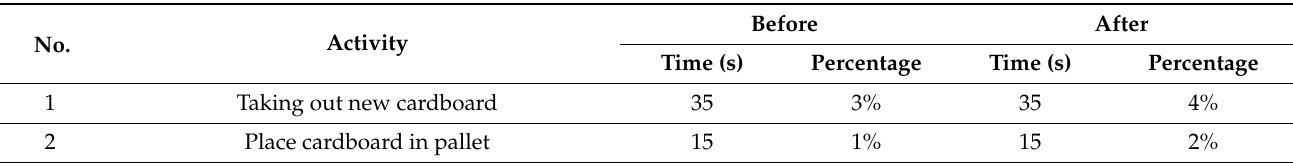
Table 6. Benefits of the vacuum